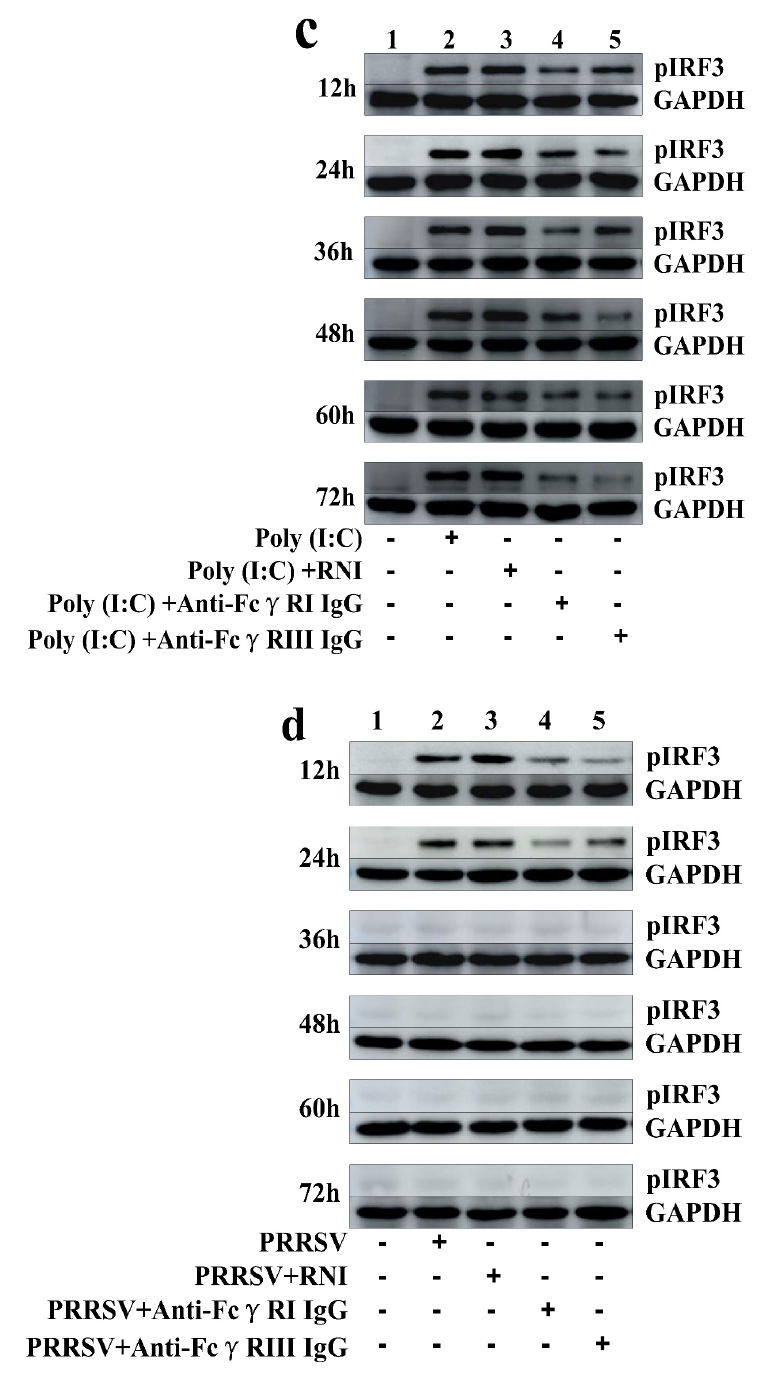
Figure 4. Immunoblot analysis of pIRF3 in porcine AMs. ( a ) Immunoblot analysis of pIRF3 in mock cells, poly (I:C)-stimulated cells, PRRSV-infected cells, PRRSV + PNI-infected cells or PRRSV + ICs-infected cells. ( b ) Immunoblot analysis of pIRF3 in cells treated with RNI, anti-Fc γ RI IgG or anti-Fc γ RIII IgG. ( c ) Immunoblot analysis of pIRF3 in poly (I:C)-stimulated cells pretreated with RNI, anti-Fc γ RI IgG or anti-Fc γ RIII IgG. ( d ) Immunoblot analysis of pIRF3 in PRRSV-infected cells pretreated with RNI, anti-Fc γ RI IgG or anti-Fc γ RIII IgG. The GAPDH served as a loading control. Note: PRRSV + PNI: PRRSV + porcine-negative IgG; PRRSV + ICs: PRRSV + porcine IgG against PRRSV; RNI: rabbit-negative IgG; pIRF3: phosphorylated interferon regulatory factor 3; GAPDH: glyceraldehyde-3-phosphate dehydrogenase; Fc γ RI: Fc gamma receptor I; Fc γ RIII: Fc gamma receptor